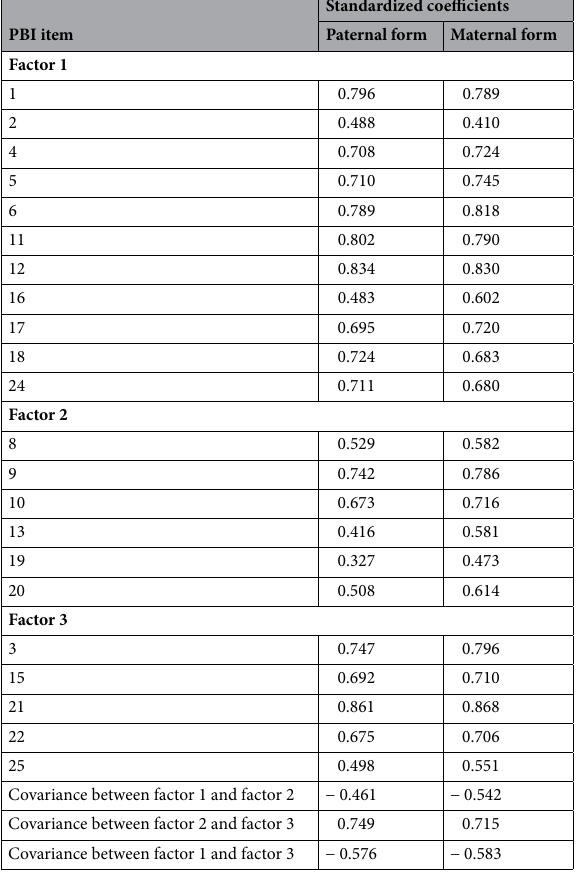
Paternal form Maternal form CFI RMSEA CFI RMSEA